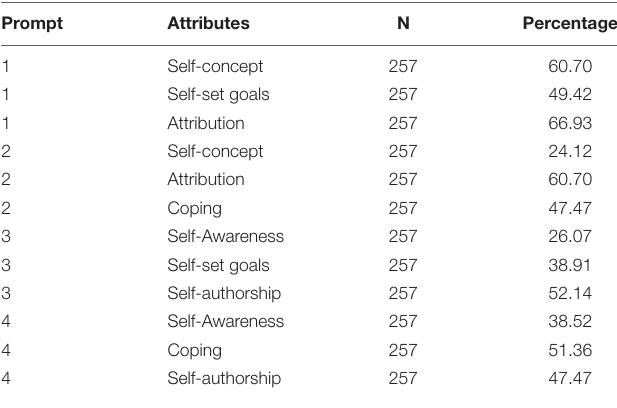
TABLE 2 | Percentage of students displaying an MD attribute by